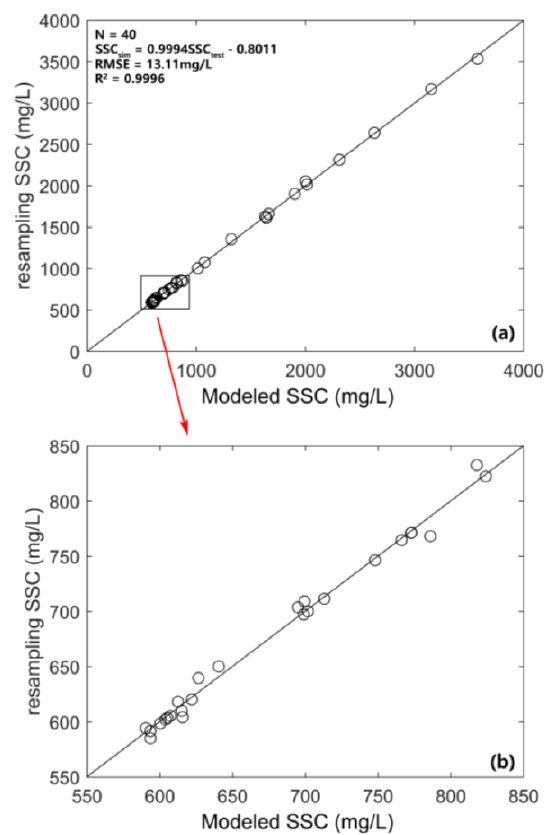
Figure 3. Linear fitting plot of the sampling SSC test (in situ data) and the SSC sim (model reversed SSC) based on the cubic polynomial fitting model. ( a ) The detailed distribution for points of the small black box shown in ( b ).